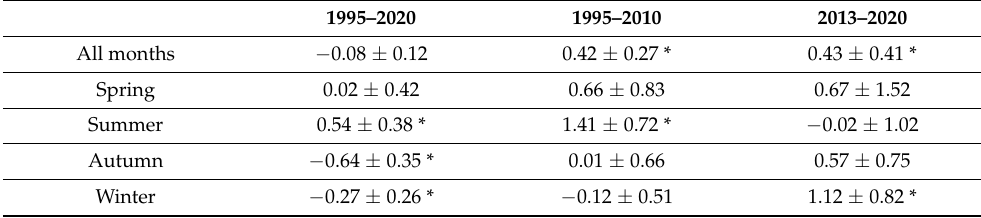
Table 1. The linear trends (ppbv year − 1 ) of Beijing surface ozone mixing ratio in different periods and different seasons. The trends with “*” passed the 95% significance